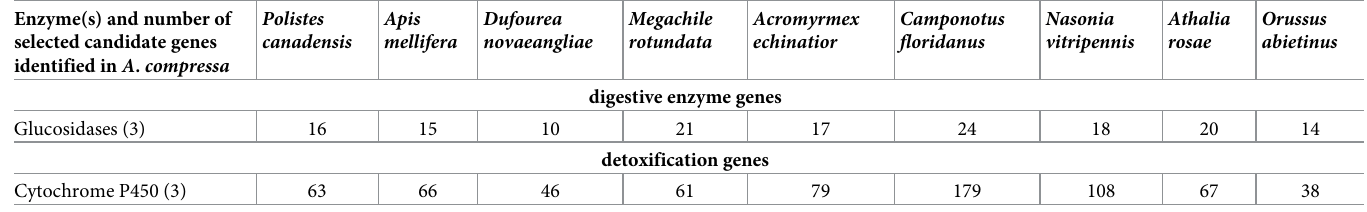
Table 9. BLAST homologous hit table. Enzyme(s) and number of Polistes selected candidate genes canadensis identified in A . compressa Glucosidases (3) Cytochrome P450 (3) Selected gut-biased candidate genes putatively involved in digestion (glucosidases, EC: 3.2.1.20) and detoxification (cytochrome P450, EC: 1.14) identified in A . compressa blasted against the NCBI refseq-protein database with a cut-off E-value of 10 − 5 . The BLAST-search was restricted to nine representative Hymenoptera species with well-known and annotated genome. Shown are the numbers of homologous hits found for the respective